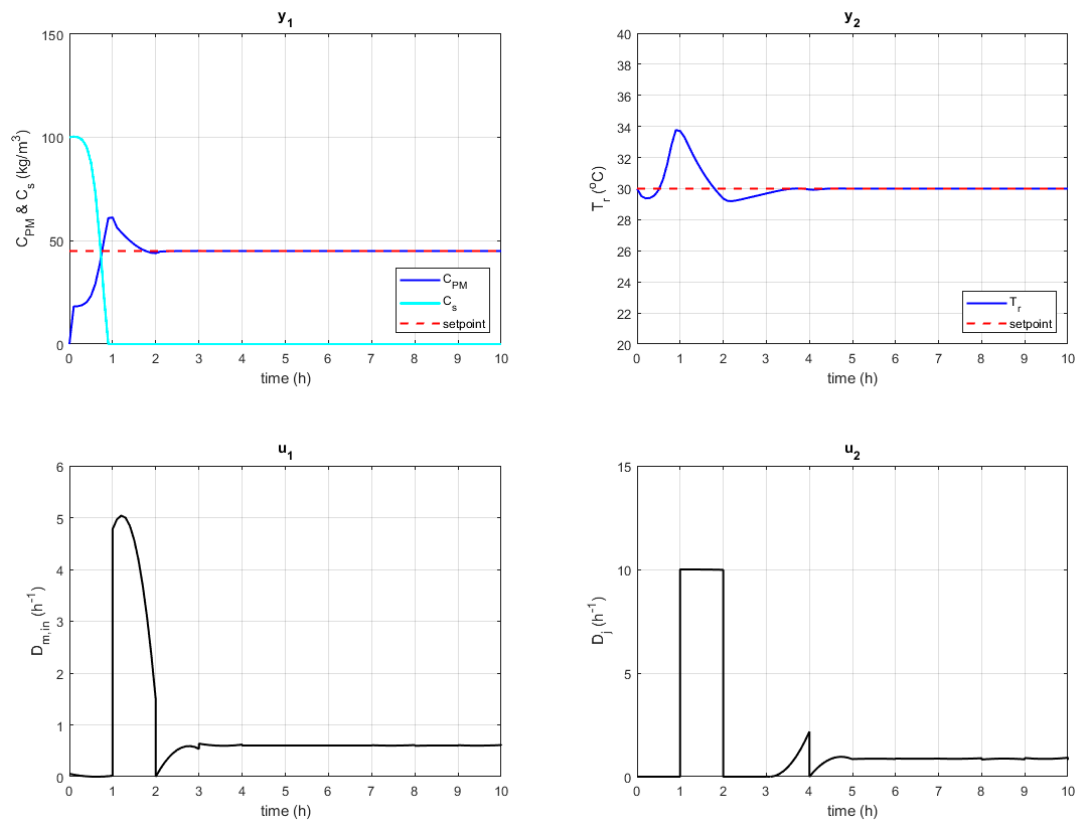
Figure 6. Case 1—closed-loop simulation without sustainability constraint: output (y 1 and y 2 ) and input (u 1 and u 2 ) profiles.